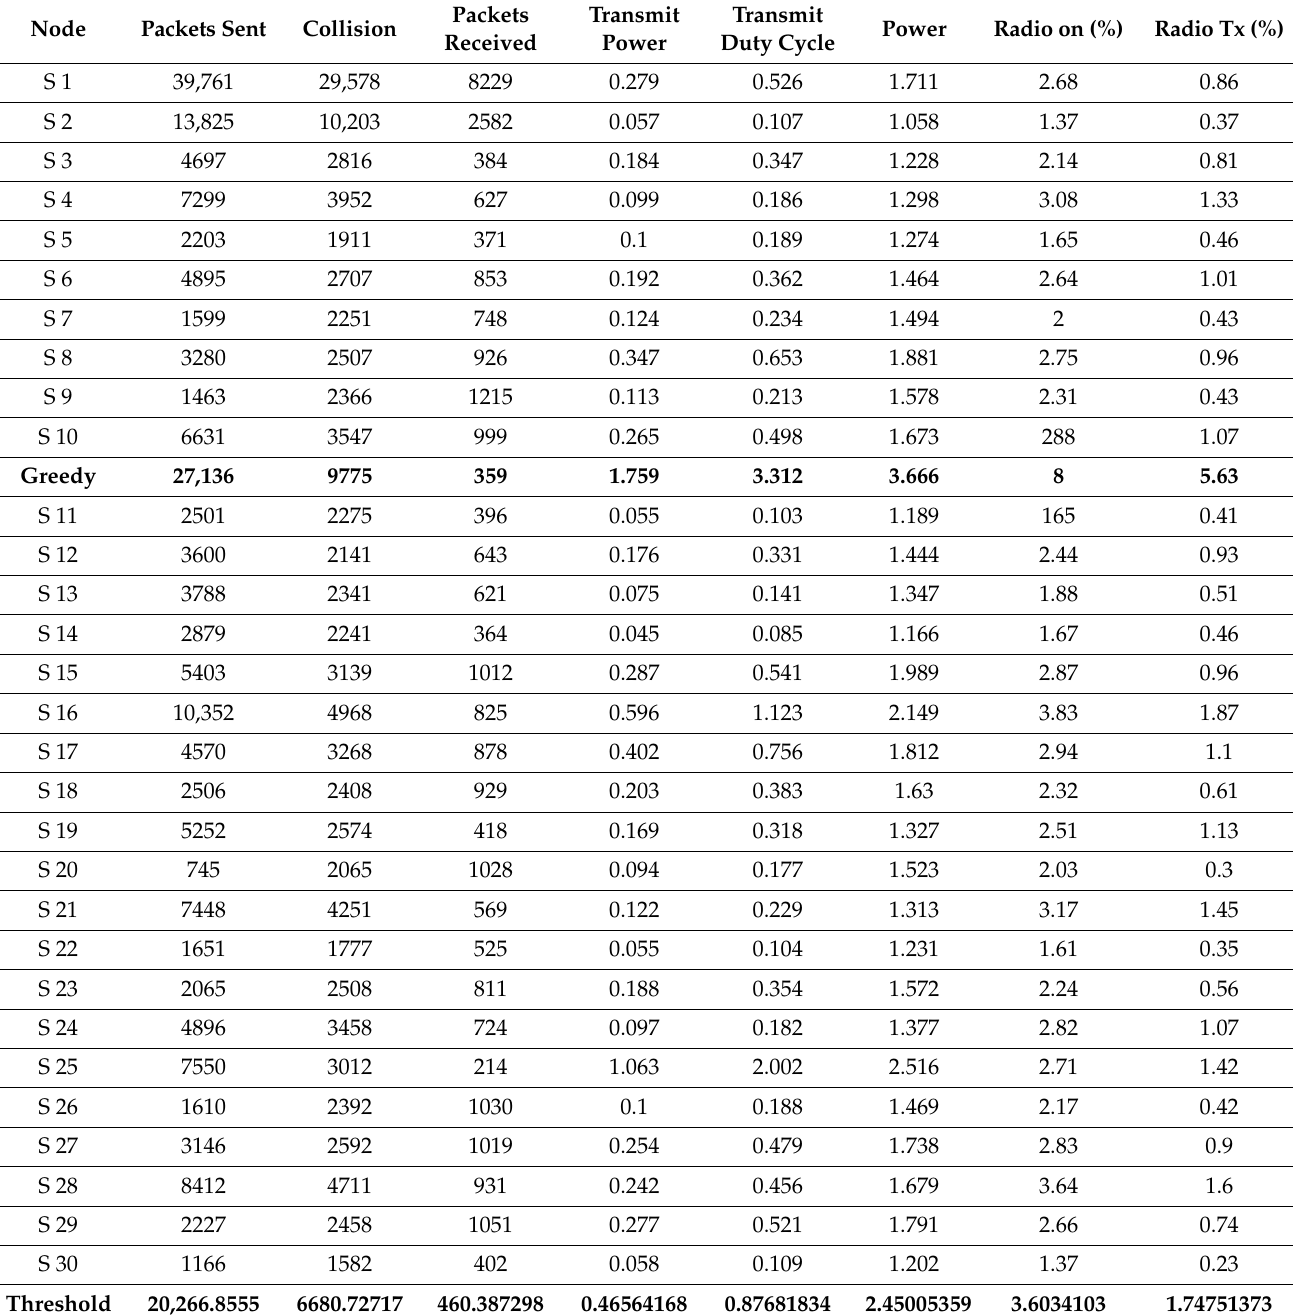
Table 5. The N 6 network